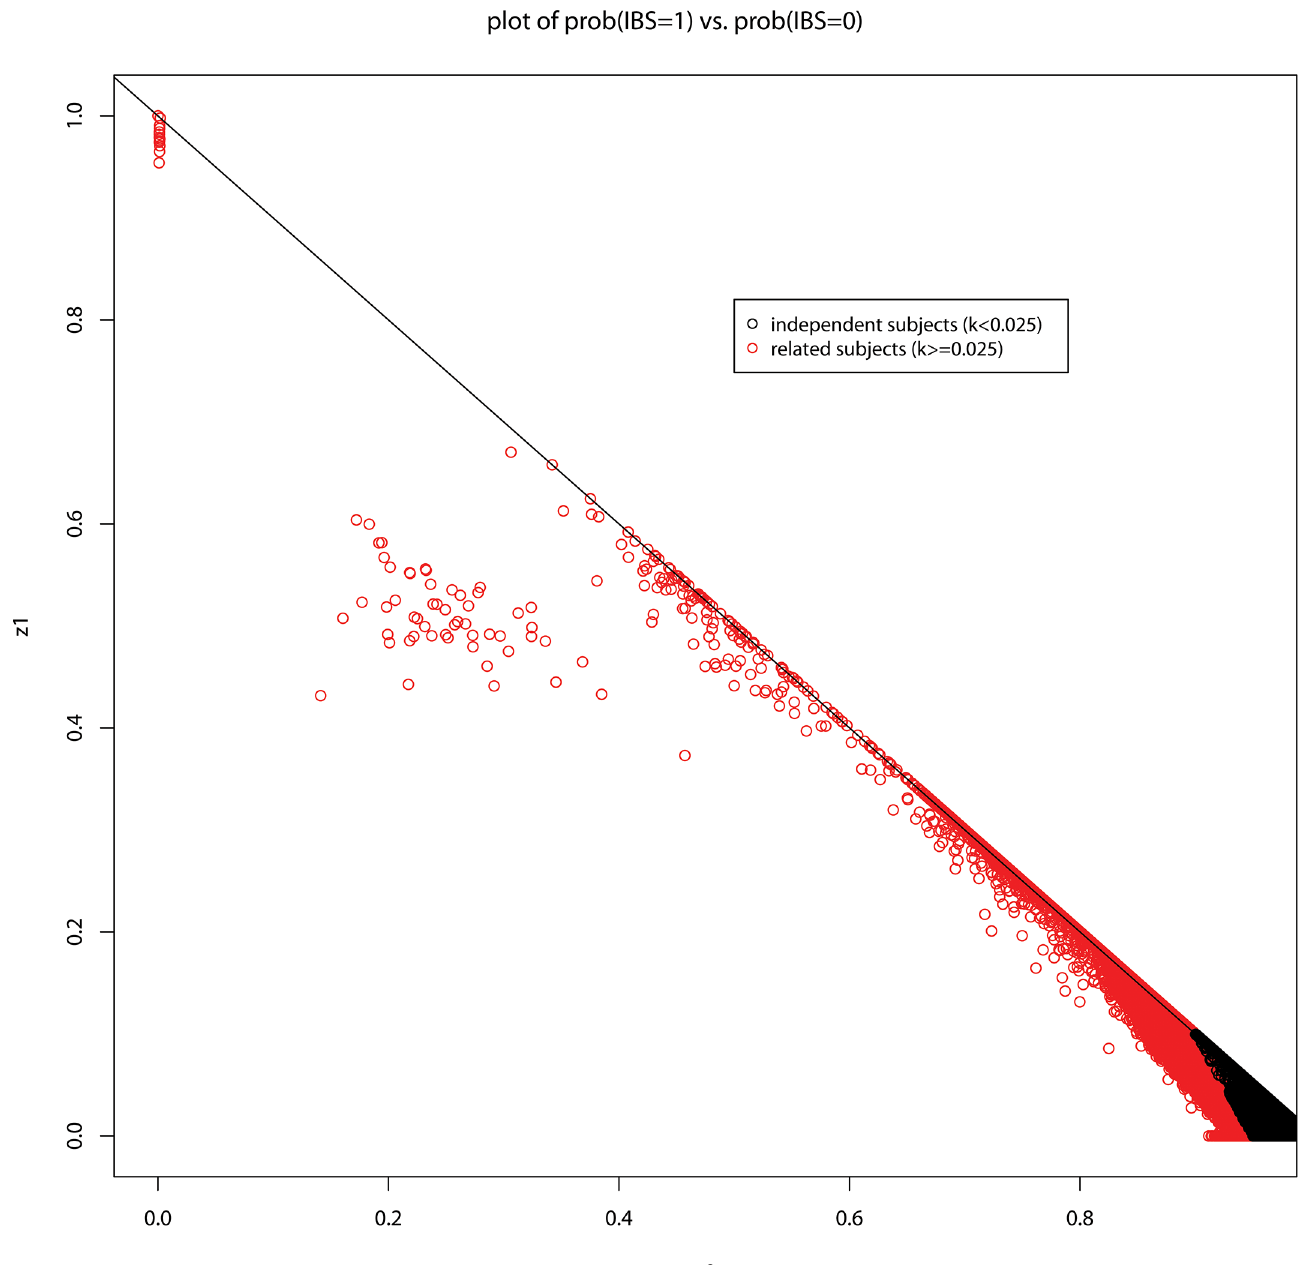
Fig 1. Relatedness in the African Ancestry Sample. A plot of the probability of sharing 1 allele identical by descent against probability of sharing zero